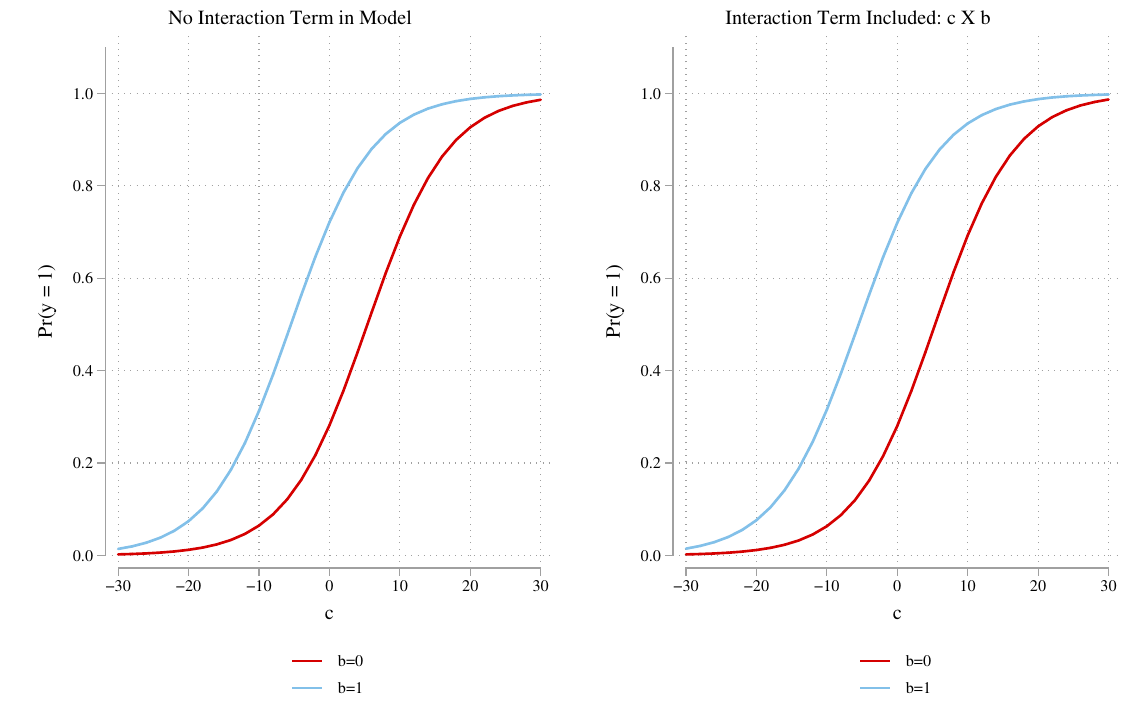
Figure 7: Effect of unneeded product term: the true coefficient on the product term is effectively